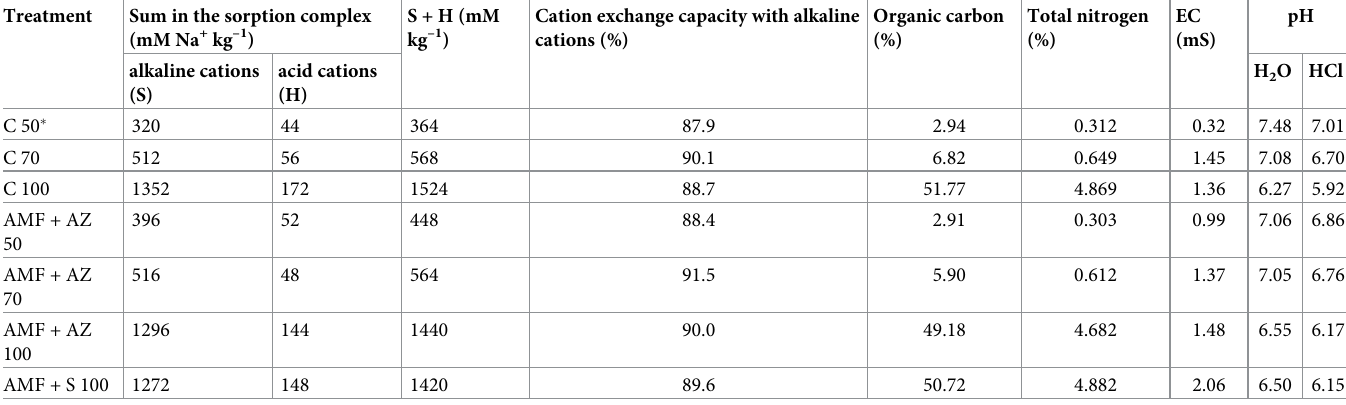
Table 2. Effects of soil microorganisms on substrate physical and chemical characteristics after tomato transplants cultivation. Treatment Sum in the sorption complex (mM Na + kg –1